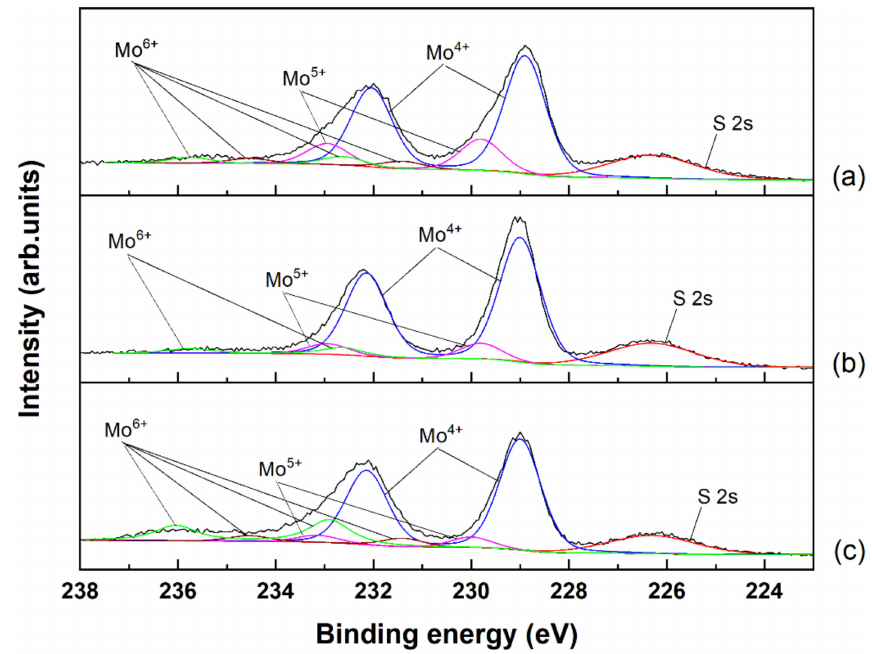
Figure 5. Mo 3d XPS spectra of MoS 2 samples prepared at ( a ) pH 4.5; ( b ) pH 7.0; and ( c ) pH 9.5.